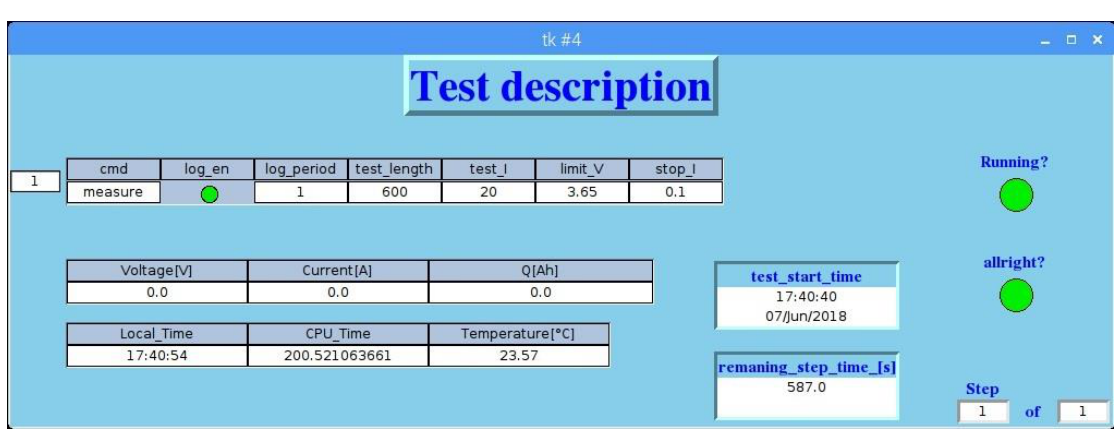
Figure 7. The window opened while the software application is executing the periodic task.